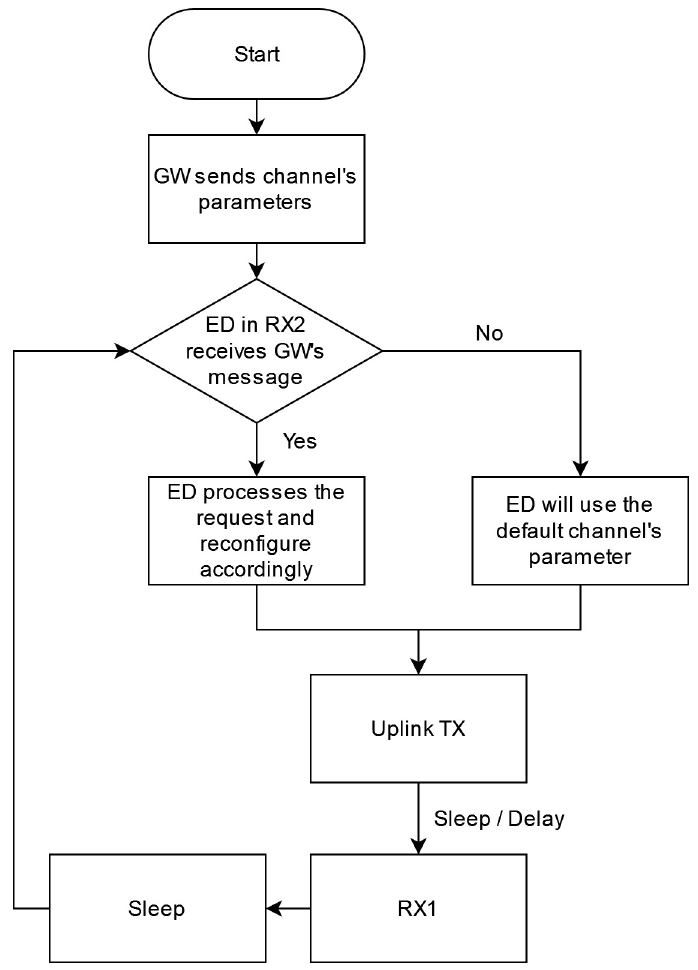
Figure 5. LoRaCog